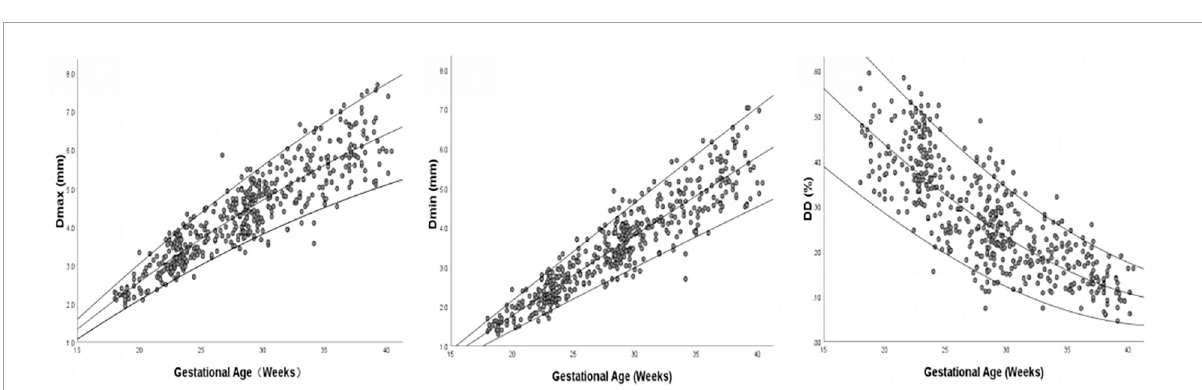
This study employed the Z-score model to reflect the diameter distensibility of the fetal ascending aorta as a multiple of SD , and gave the typical 90% range of Z-score, that is,